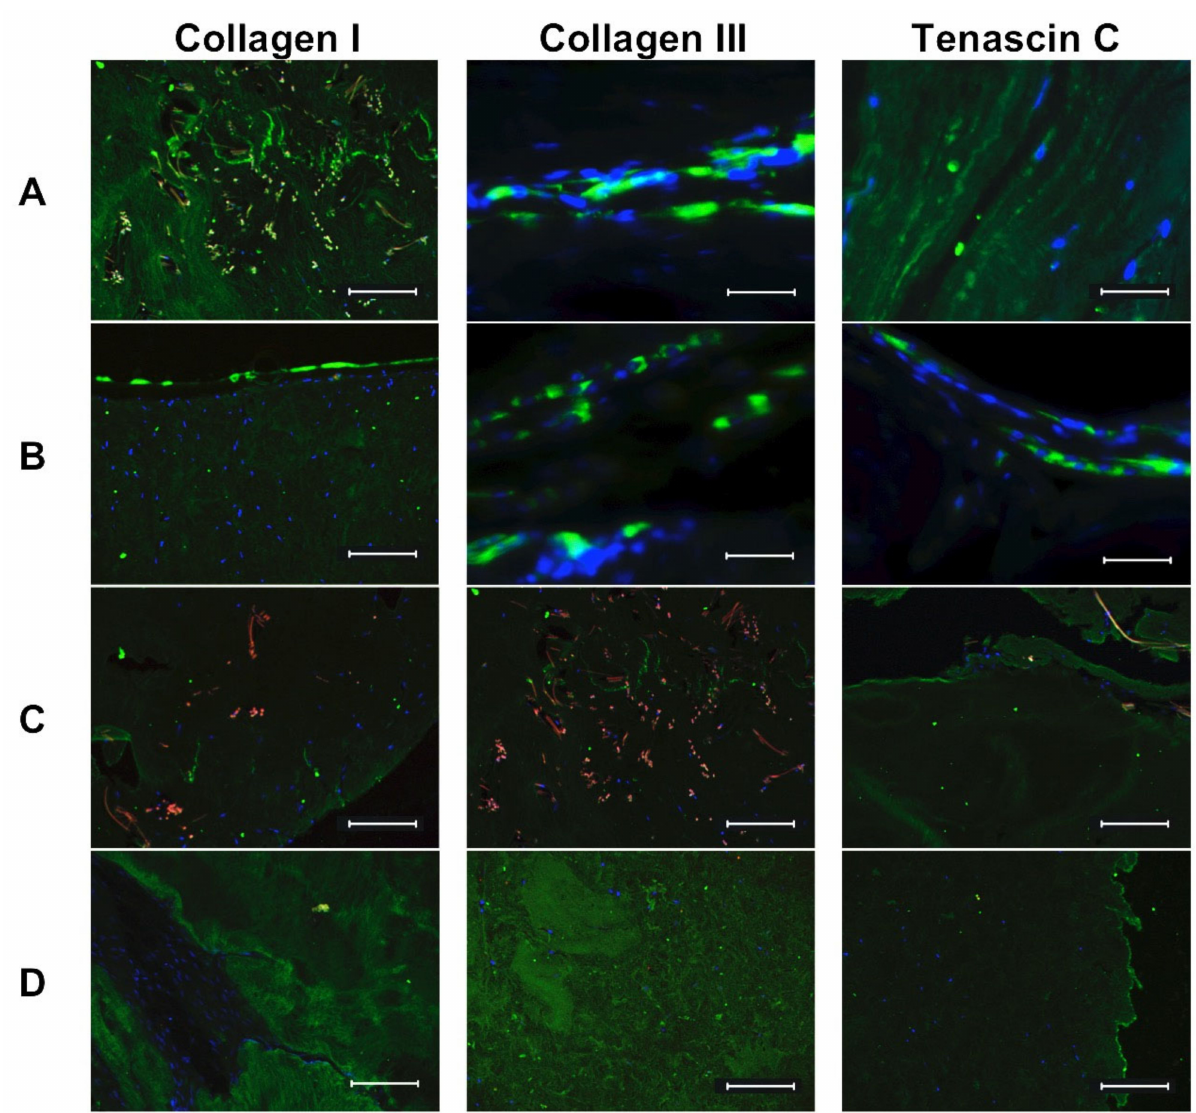
Figure 7. Results of the immunohistological staining. The cell nuclei were stained with 4 (cid:48) ,6-diamidino-2-phenylindole (DAPI) and can be recognized by a blue fluorescence. The target proteins each show a green fluorescence. The spider silk shows a red autofluorescence. The measurement bars represent 200 micrometers. ( A ) Results of experimental group A. ( B ) Results of experimental group B. ( C ) Results of experimental group C. ( D ) Results of experimental group